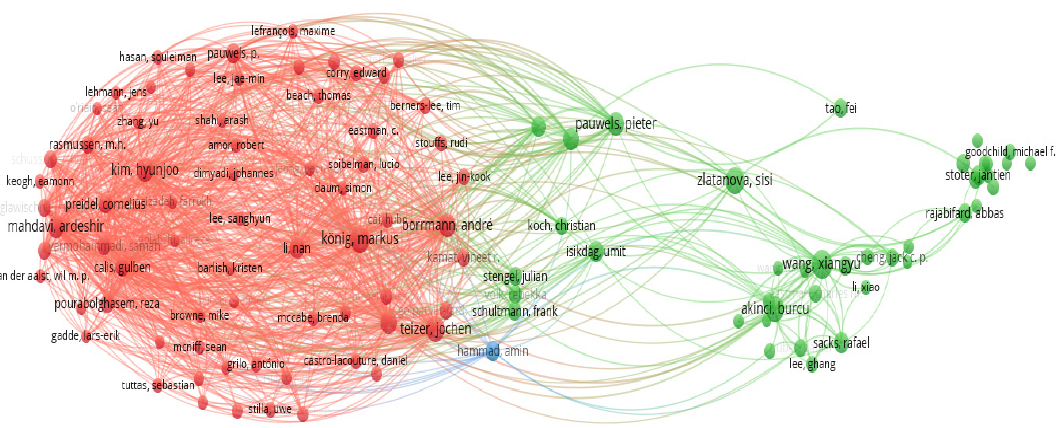
Figure 6. VOSviewer mapping of CityGML deployment in the Internet of Robotic Things regarding co-citation.